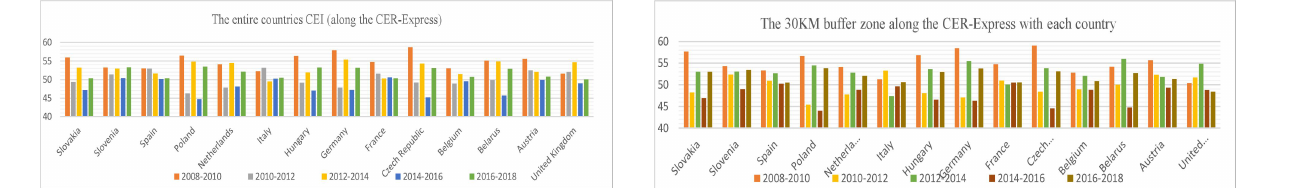
Fig. 5. From 2008-2018, the mean CEI values falling within 30 kilometers buffer zone of CER-Express Express (European section) were calculated every two years, with the X-axis corresponding to the countries involved in the area along the route and the Y-axis corresponding to the mean CEI